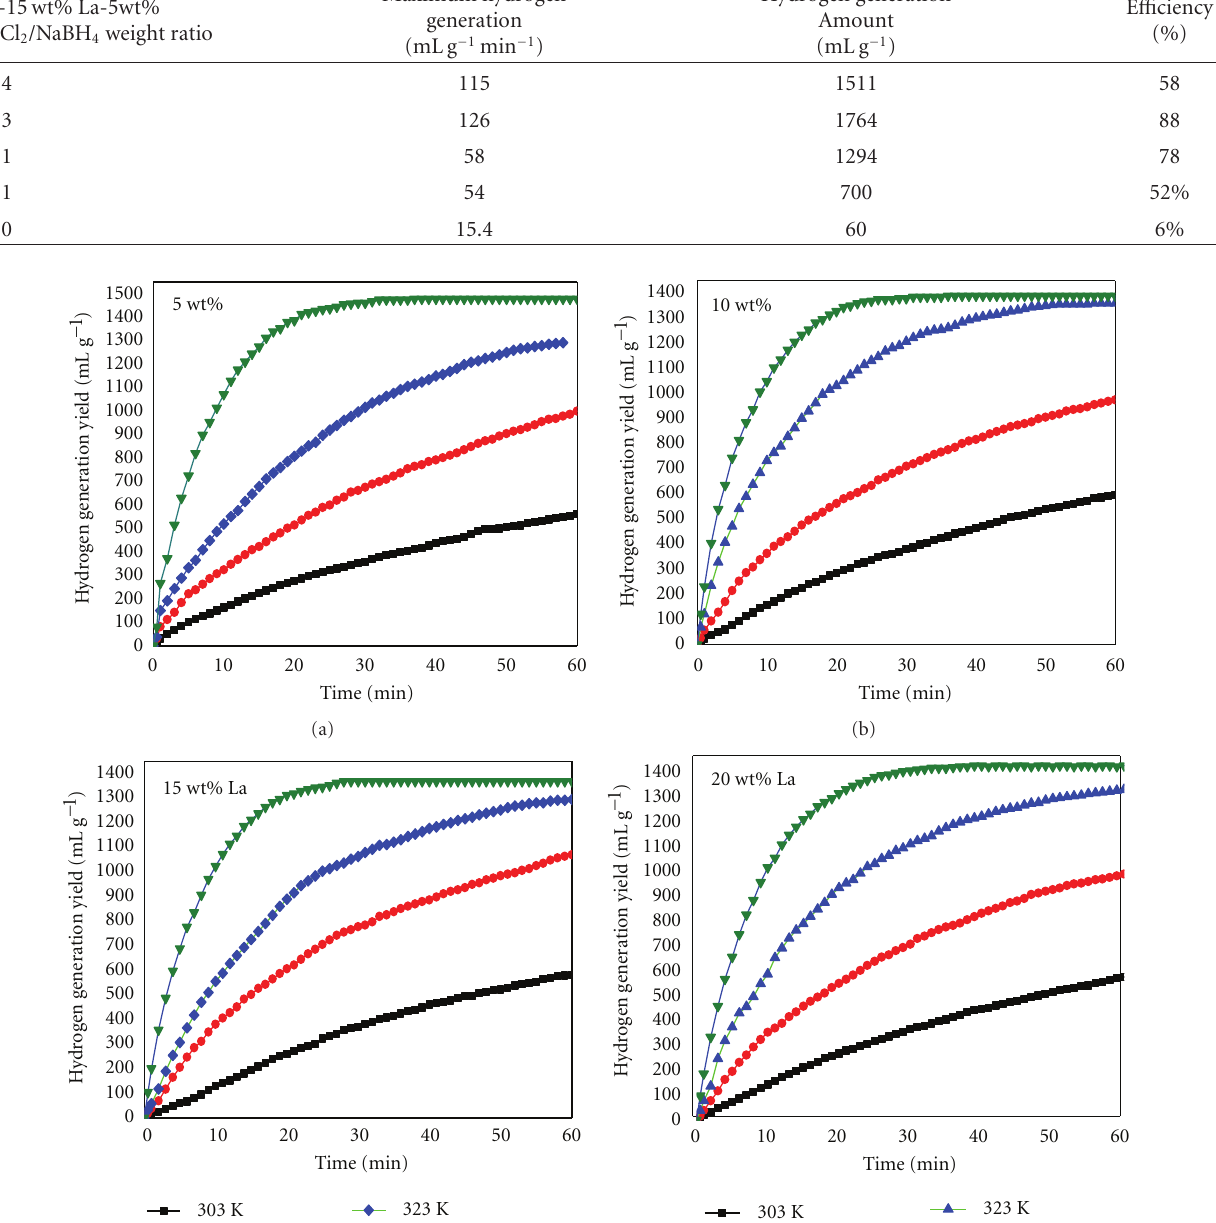
Table 1: Hydrogen generation amount and maximum rate of Al-15 wt% La-5wt% NiCl 2 /NaBH 4 with di ff erent weight ratios. Al-15wt% La-5wt%